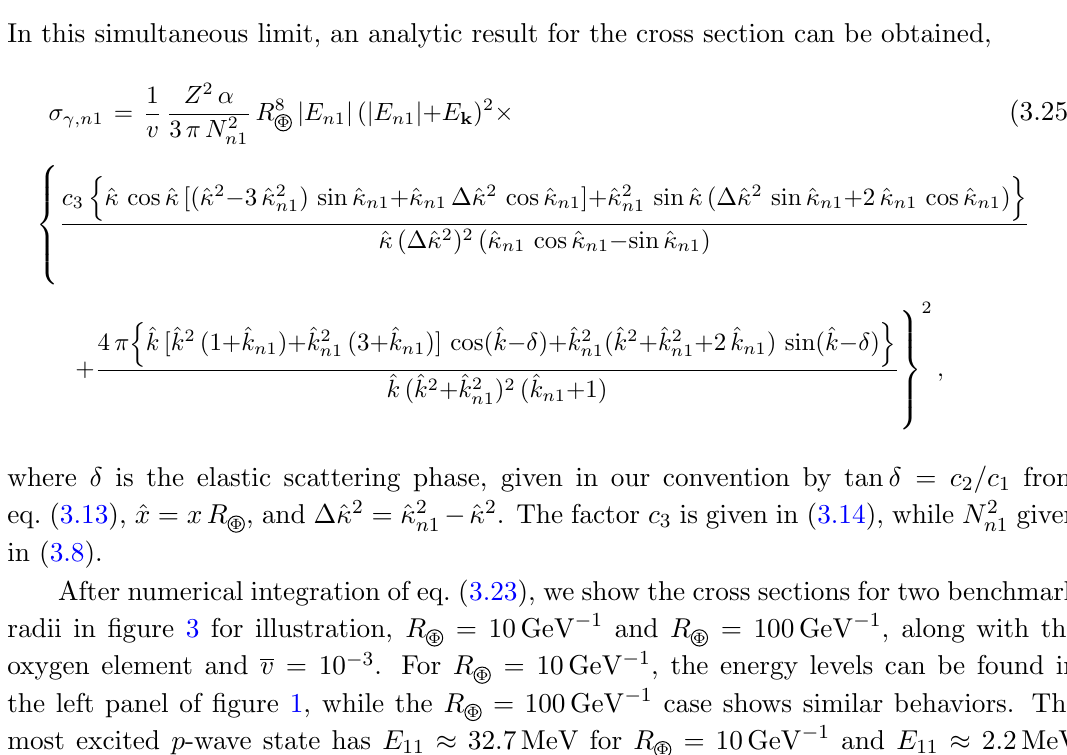
Figure 3 . Radiative capture cross section as a function of the binding energy of the bound states for Z = 8, A = 16, V 0 = A (cid:2) 32 MeV and (cid:22) v = 10 (cid:0) 3 , as well as R R = 100 GeV (cid:0) 1 (cid:8)